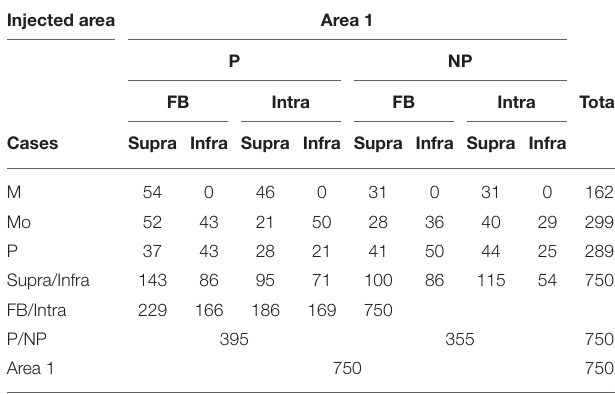
TABLE 3 | The number of boutons in different pathways labeled by area 3b injection in different cases. Injected area